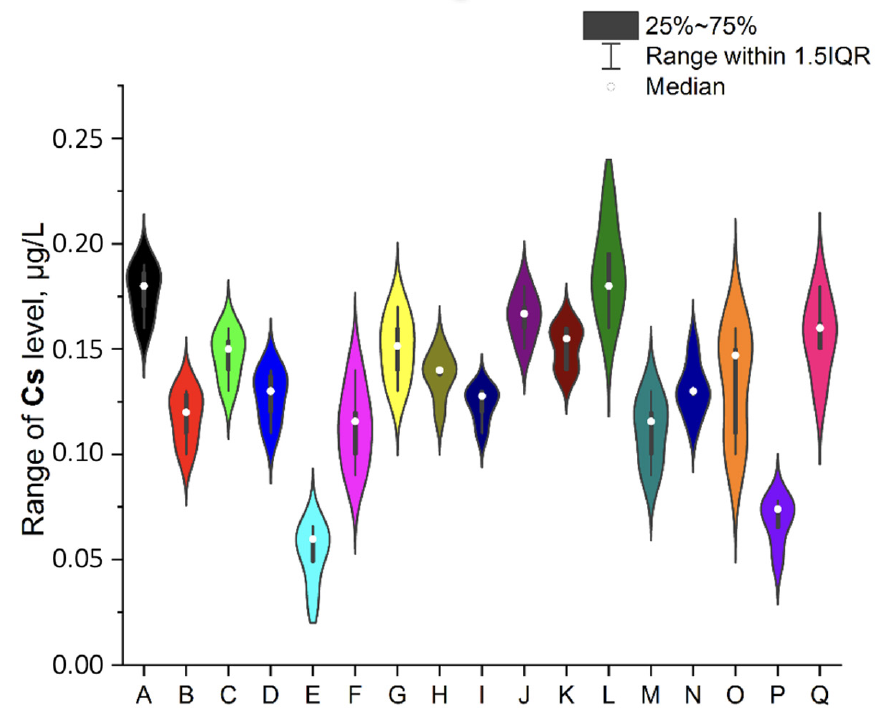
Figure 3. The plot as a violin with the box for the Cs level ( µ g/L) in the examined products (A–Q).